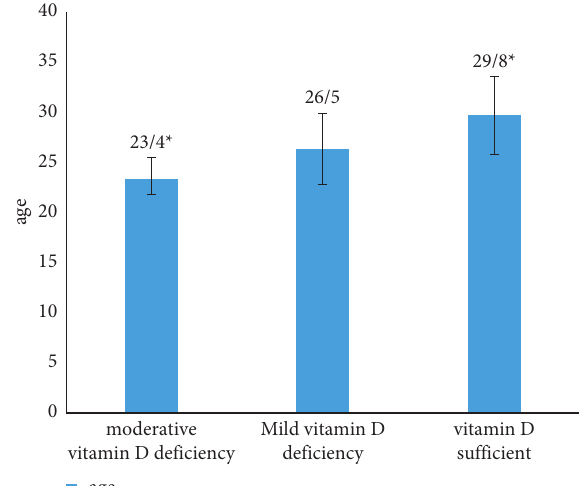
Figure 1: Age of participants based on the vitamin D status in the 3 rd trimester. Mean age of participants based on serum vitamin D status: severe vitamin D deficiency, serum 25OHD levels ≤ 8ng/ml; moderate vitamin D deficiency, serum 25OHD levels from 8ng/ml to 15ng/ml; and mild vitamin D deficiency, serum 25OHD levels from 15ng/ml to ≤ 20ng/ml. ∗ P value less than 0.05 is considered